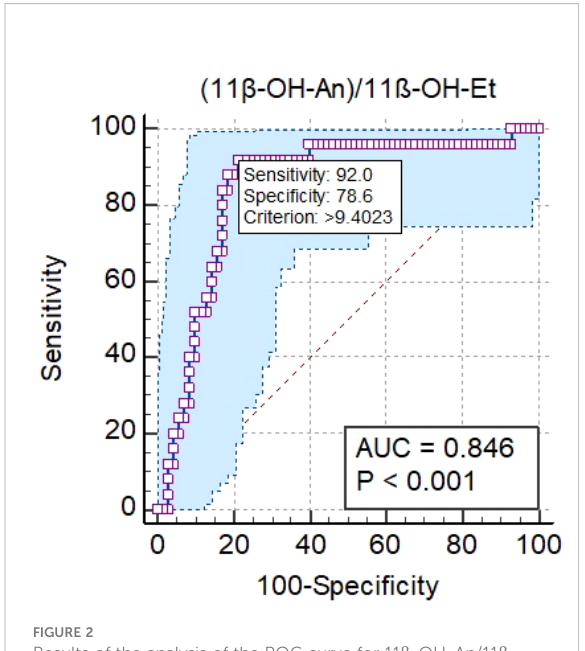
FIGURE 2 Results of the analysis of the ROC curve for 11 b -OH-An/11 b - OH-Et ratio. The blue shaped area is the 95% con fi dence interval of the sensitivity at the given speci fi city.